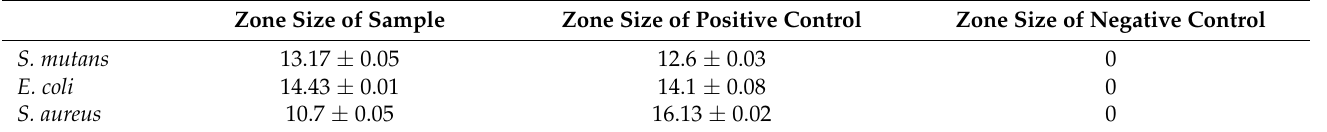
Table 1. Sizes of inhibition zones for the manufactured substances, positive and negative controls. Zone Size of Sample